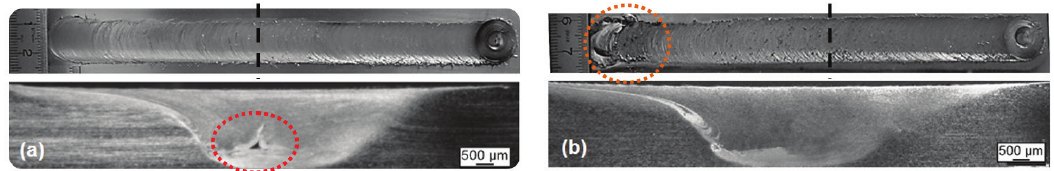
Figure 5. Macrographs of top surface and cross-section of joints: (a) SS-WRe-400 and (b) SS-WRe-600. The black lines on the top surfaces indicate the sections of